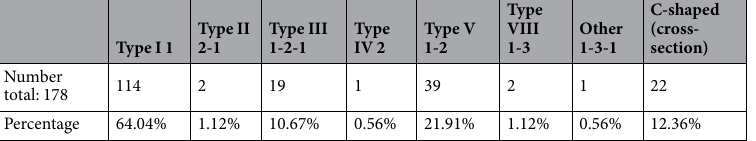
Location of LC * Number of teeth with LC